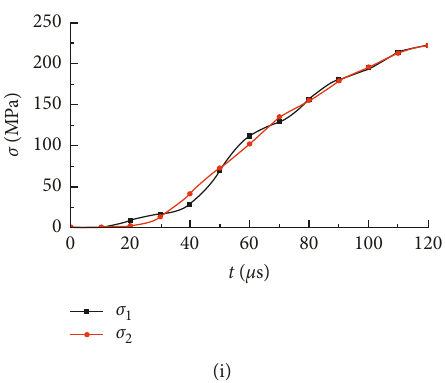
Figure 6: Stress history on two ends of nonparallel end-surface rock specimens when Young’s modulus is 28GPa: (a) c (c) c 0.10%, (d) c (cid:30)